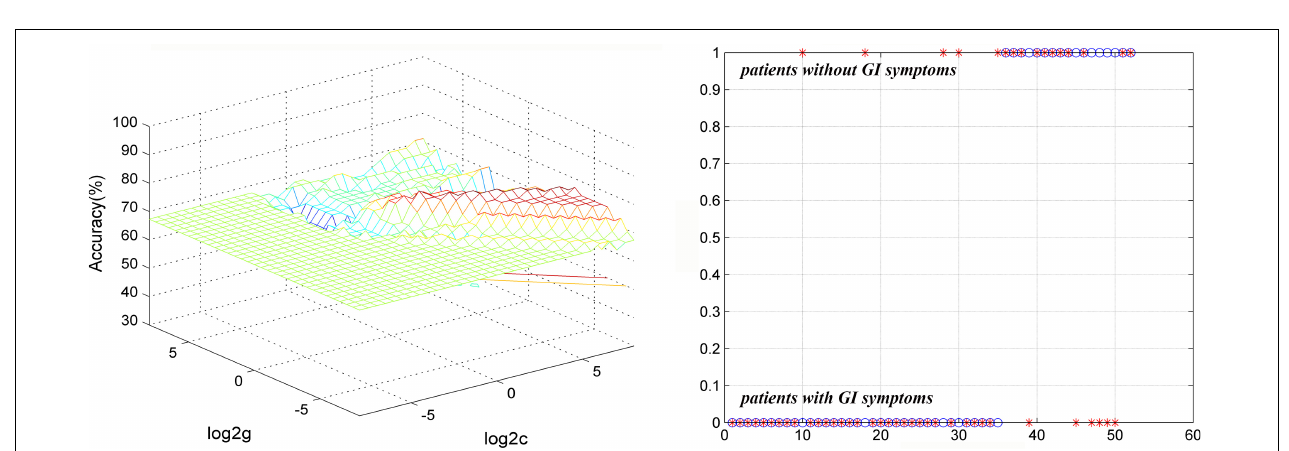
FIGURE 4 | Statistical map depicts higher and lower GFC of MDD patients without GI symptoms compared with healthy controls. Blue denotes lower GFC and red denotes higher GFC. Color bar indicates T values from two-sample t -test. MDD, major depressive disorder; GFC, global functional connectivity; GI, gastrointestinal symptoms.